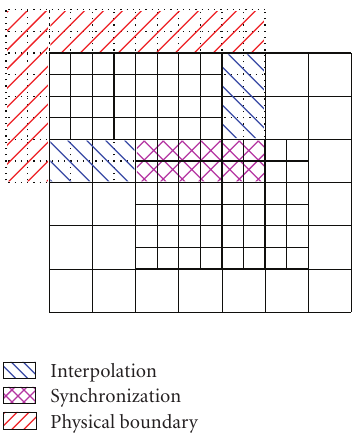
Figure 9: Sources of ghost cell values at the boundaries of an AMR